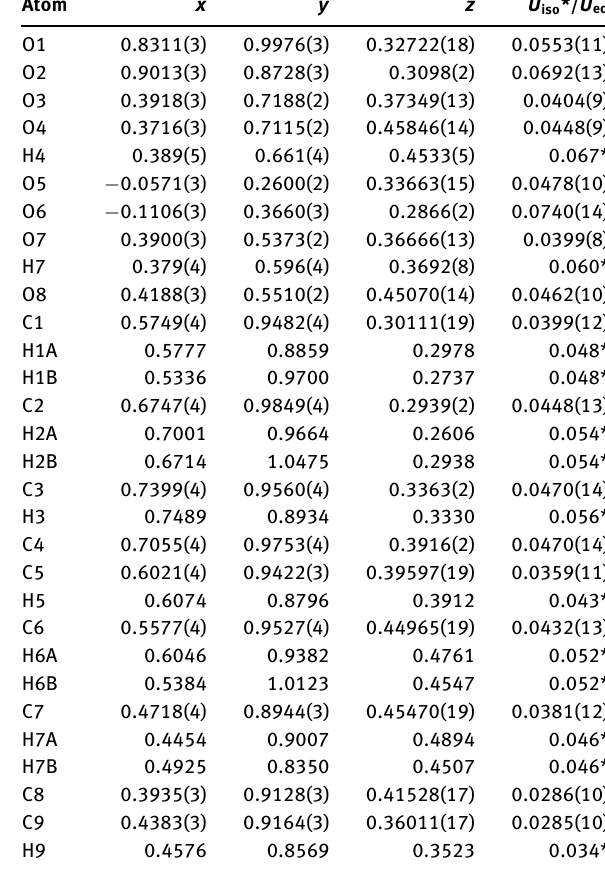
Table 2: Fractional atomic coordinates and isotropic or equivalent isotropic displacement parameters (Å 2